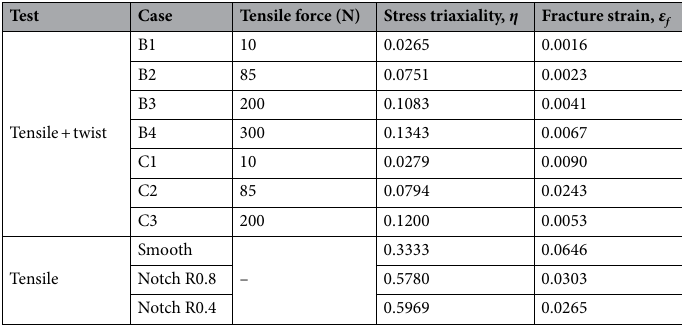
Table 1. Conditions and results of tensile and twist tests.